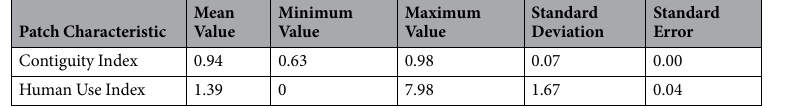
Table 1. Contiguity Index and Human Use Index of the intensive study area.